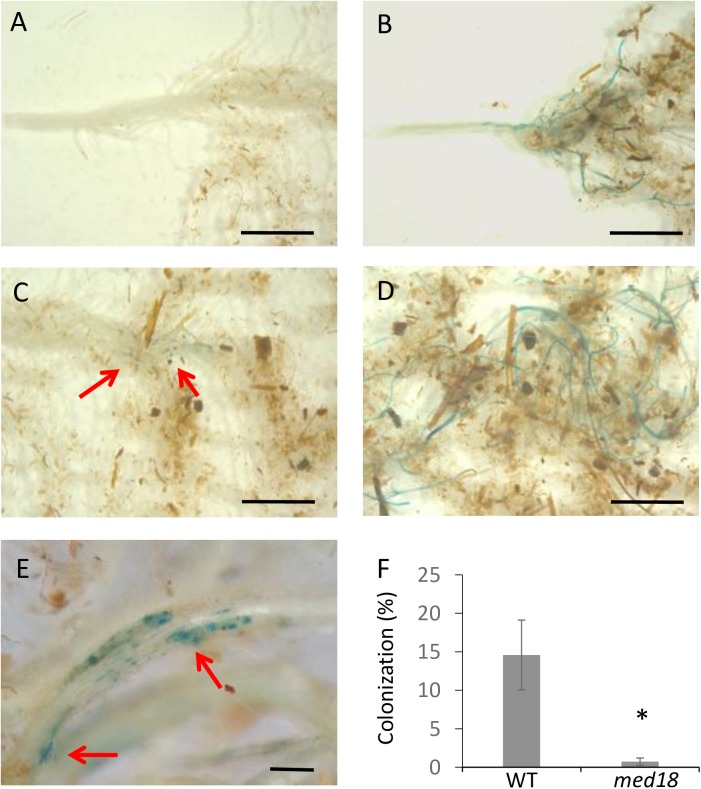
F. oxysporum shows restricted colonization in med18 roots.Ten plants of each genotype were isolated twelve days post infection with a GUS-expressing strain of F. oxysporum and stained for GUS expression. Colonization of the med18 (A, C, E) and WT (B, D) root system. Infection in the med18 root system was localized to a small region in the roots and evidence of unsuccessful infection attempts were observed (red arrows). Photos shown in (C) and (D) are the lower portion of the root system seen in (A) and (B) respectively. Photos are representative of the results for each genotype. (A-D) are imaged using a Zeiss stereomicroscope at 4x zoom and (E) imaged using a Nikon compound microscope. Scale bars represent 5mm (A-D) and 100μm (E). Colonization was scored as a percentage of the total root mass and the average shown in (F). Error bars are standard error of ten individual plants. * represents significance using Student’s T-test (p<0.05).